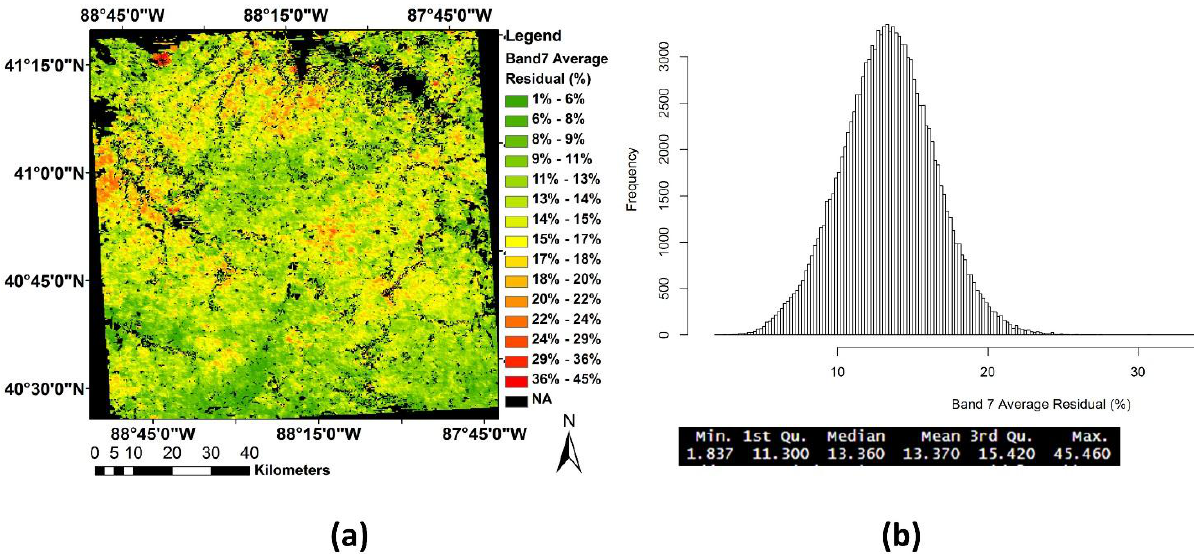
Figure 7. Percentage of average residual of band 7 predicted by linear regression model for each location in study area. ( a ) Spatial distribution of average residual (%) of band 7; ( b ) Histogram of band 7 average residual